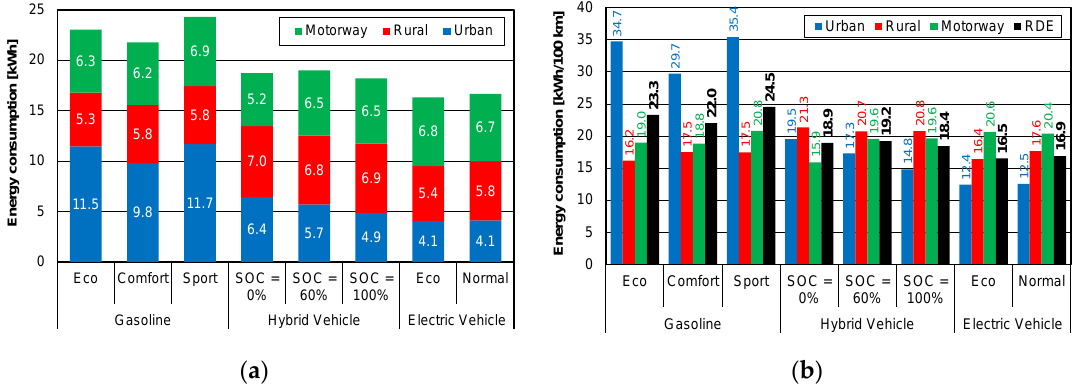
Figure 15. Energy consumption in individual portions of the RDE test by different vehicles ( a ); energy demand of the investigated vehicles per 100 km ( b ).